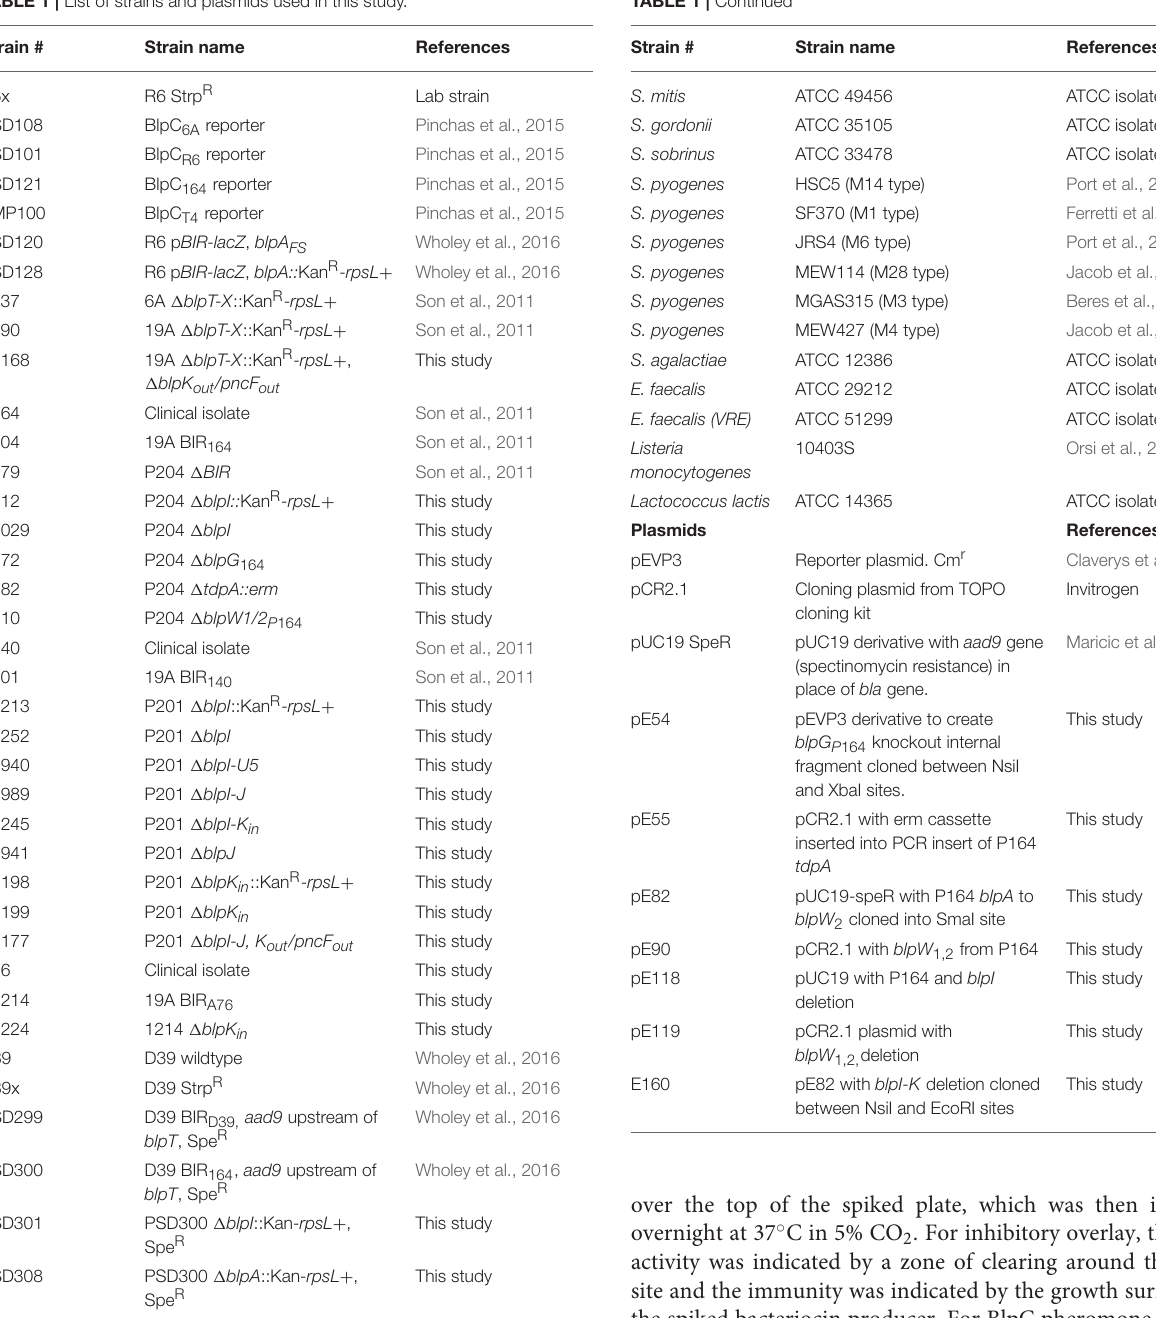
TABLE 1 | List of strains and plasmids used in this